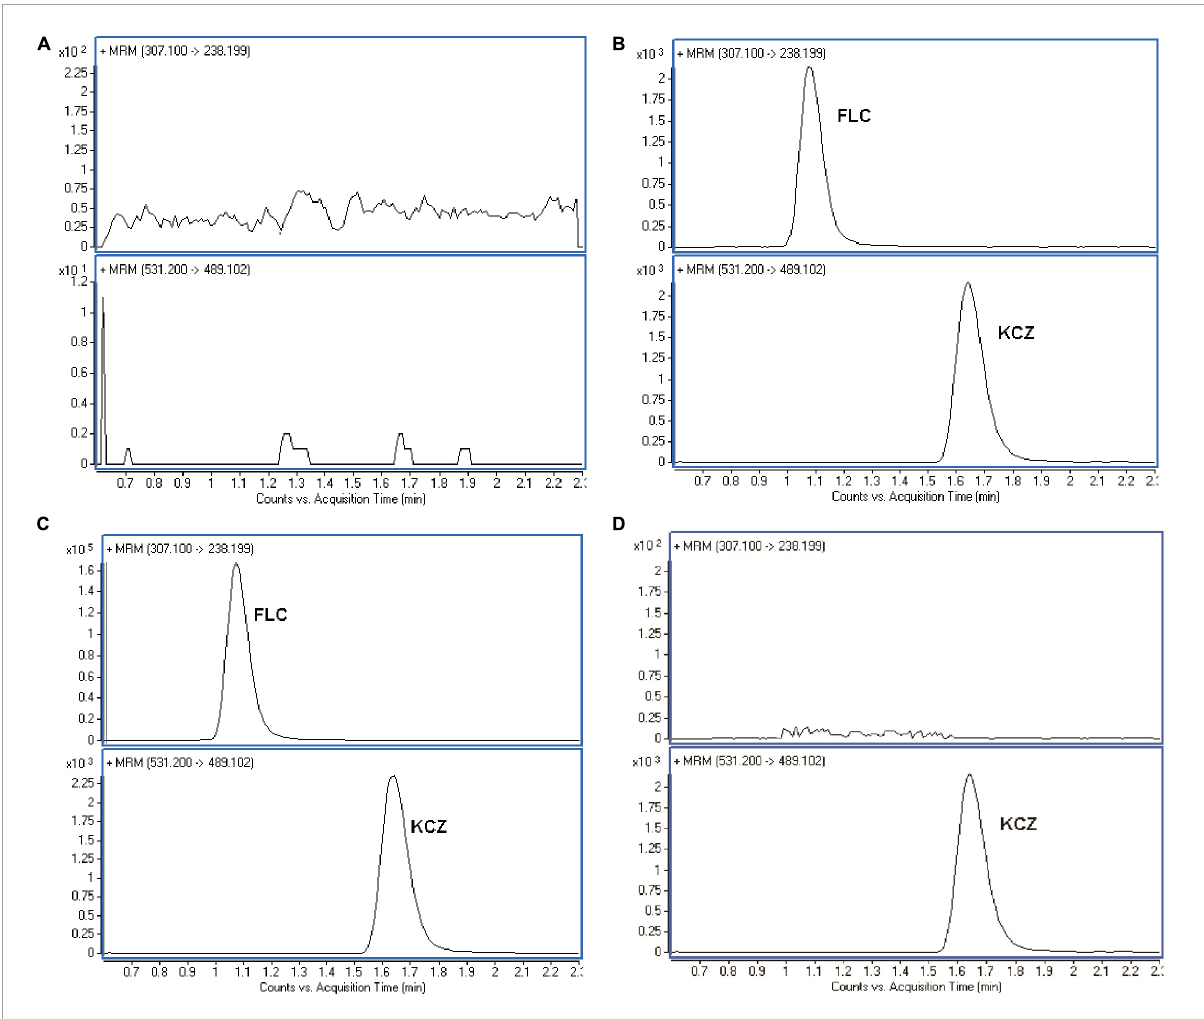
FIGURE2 Representative MRM chromatograms of FLC in C. albicans lysate. (A) Blank sample. (B) Blank sample with FLC and KCZ (internal standard). (C) The testing C. albicans lysate. (D) Blank sample with KCZ (internal standard). The representative results of three independent experiments are